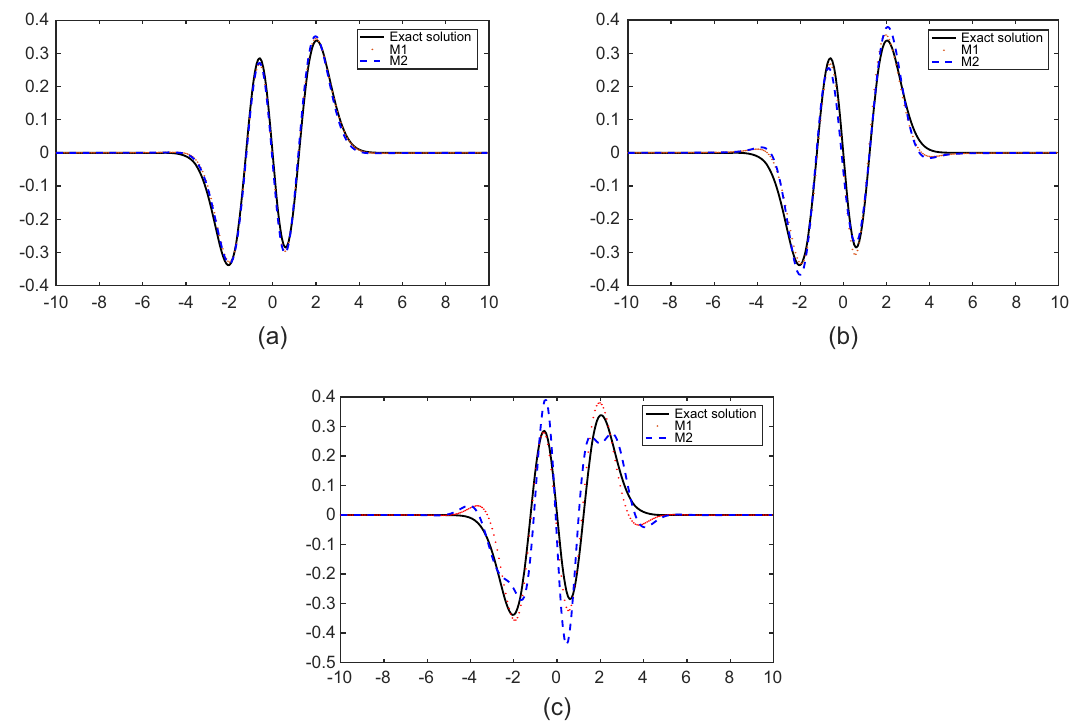
Figure 1: Comparison of exact functions and their approximation ( Example 1 ) . ( a )